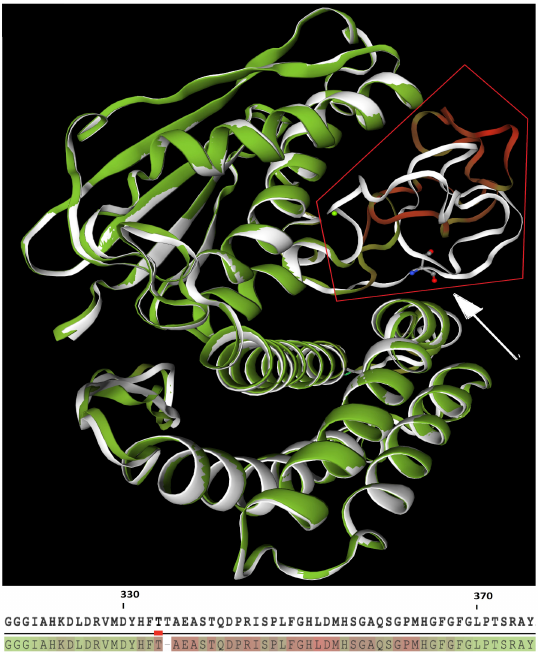
Figure 3. Upper : Structural superposition of wild-type (white structure) and mutant (green structure) BCKDK. Red frame highlights the kinase-activity domain, presenting divergent folding between WT and mutant (green/red structure) protein. White arrow points to the deleted threonine of the WT protein. Lower : relative consistency between WT ( upper line) and mutant ( lower line) proteins, where green residues have the highest consistency scores, while red one have the lowest